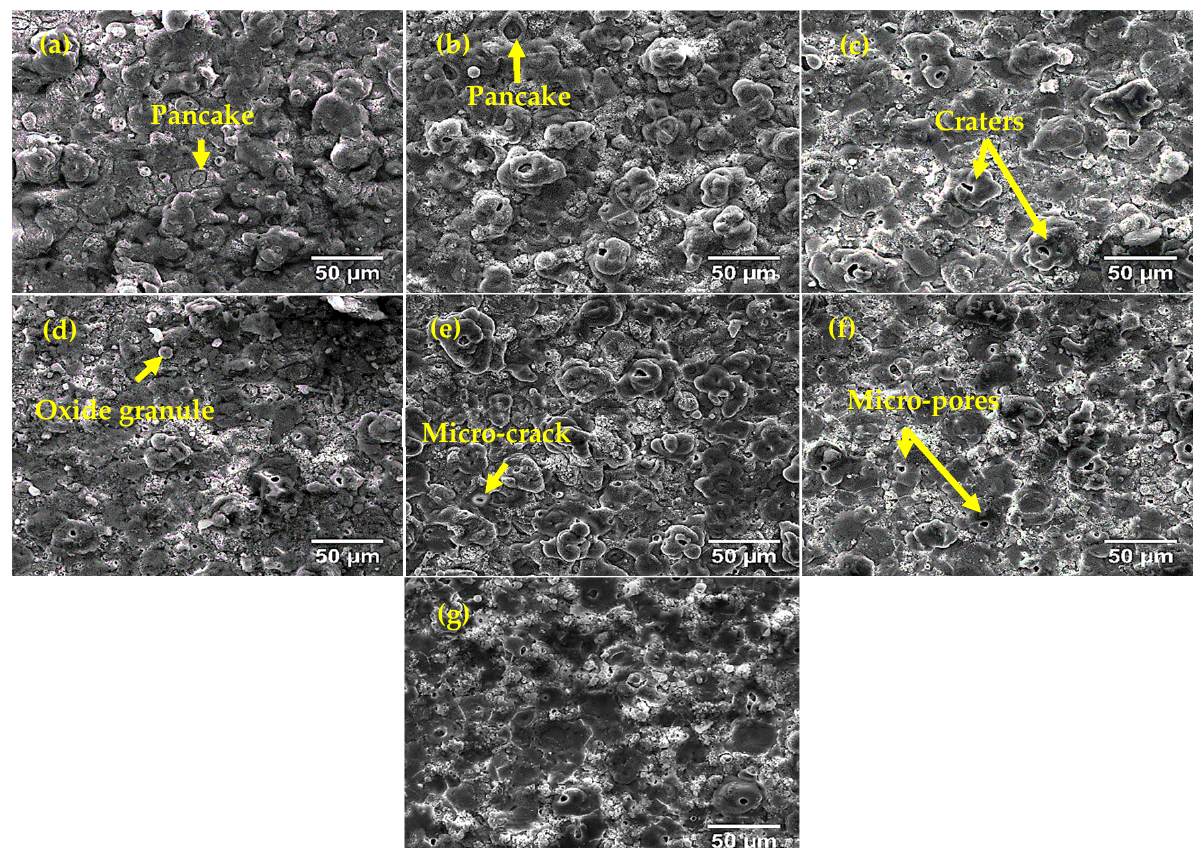
Figure 4. Surface morphology of the produced coatings: ( a ) S1, ( b ) S3, ( c ) S5, ( d ) S7, ( e ) S9, ( f ) S11, and ( g ) S13.